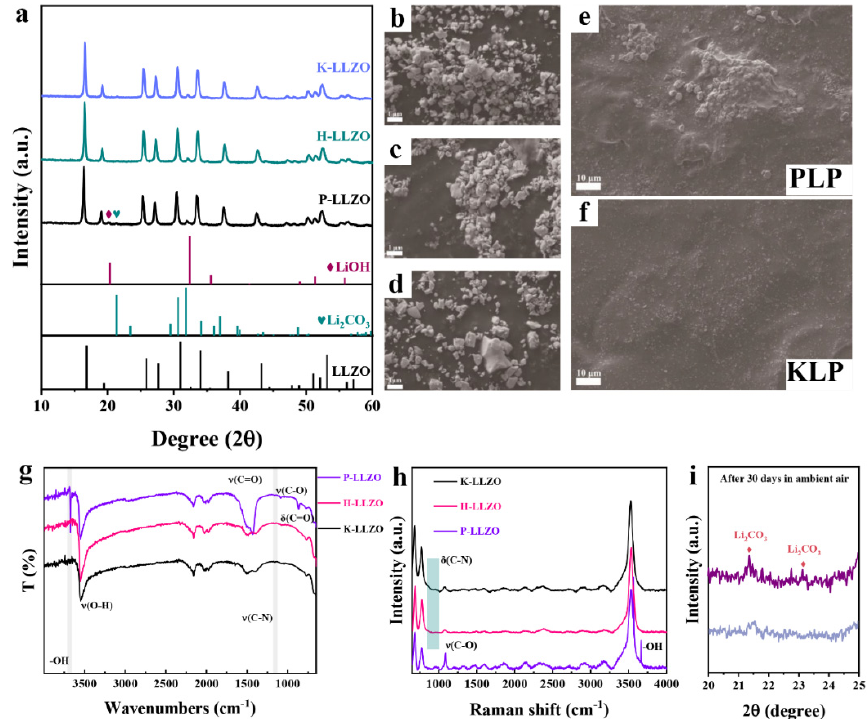
Figure 2. ( a ) XRD patterns of each LLZO powder; Particle SEM morphology ( b ) P − LLZO, ( c ) H − LLZO, ( d ) K − LLZO; Composite solid electrolyte SEM morphology ( e ) P − LLZO@PEO (PLP), ( f ) K − LLZO@PEO (KLP); ( g ) FTIR and ( h ) Raman spectra of different LLZO powders; ( i ) Enlarged XRD patterns of K − LLZO (the curve above) and H − LLZO (the curve below) after 30 days in ambient air.